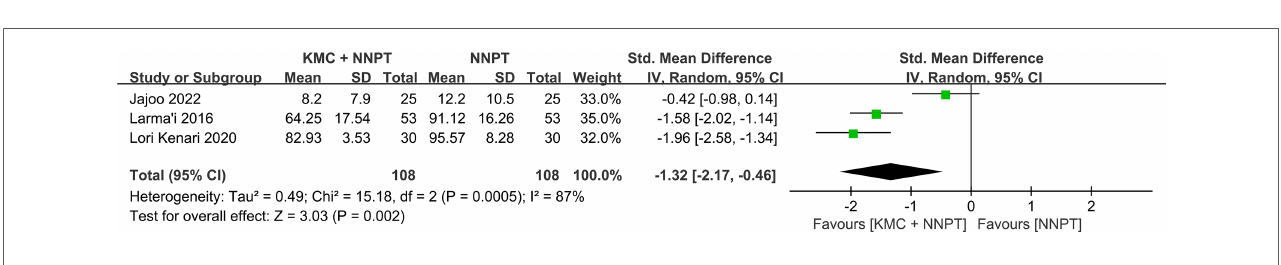
FIGURE 5 Forest plot comparing KMC+NNPT with NNPT alone on the duration of hospitalization in neonates with non-pathological